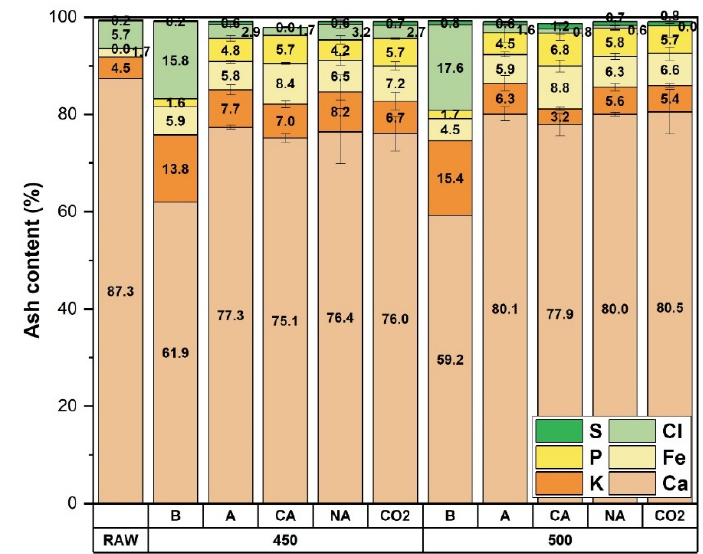
Figure 5. X-ray fluorescence (XRF) results for raw food waste feedstuff and biochar, after different demineralization treatments.